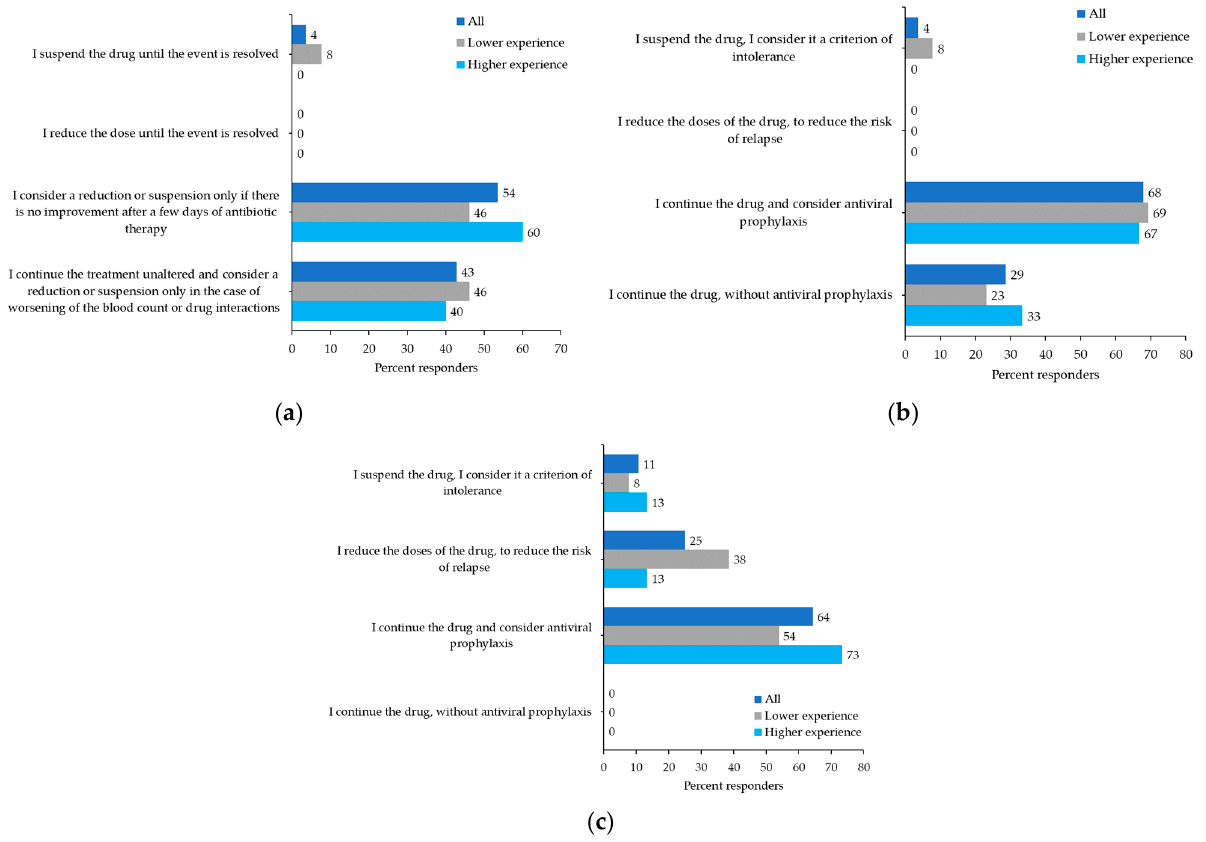
Figure 6. Participant preferences: ( a ) How do you manage treatment in a patient with myelofibrosis (MF) on stable doses of ruxolitinib who has an intercurrent bacterial infectious event? ( b ) How do you manage treatment in a patient with MF on stable doses of ruxolitinib who has a first episode of herpes zoster reactivation or ( c ) who has two or more episodes of herpes zoster reactivation?